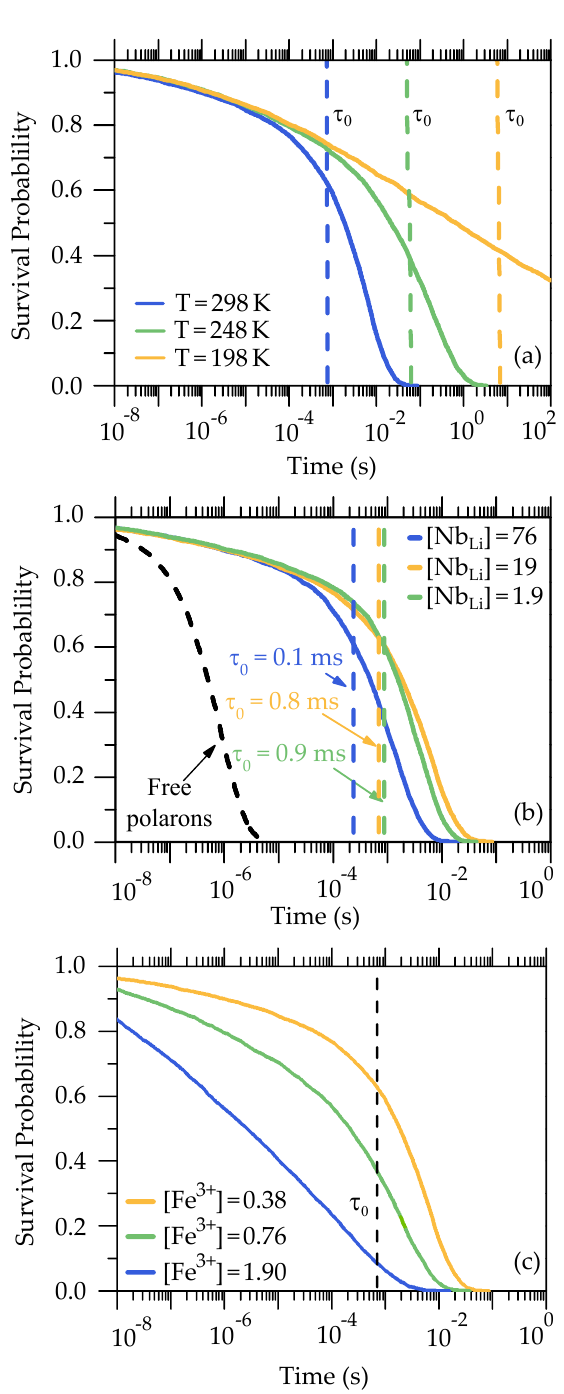
Figure 3. ( a ) Survival probability of P polarons at 298 K, at 248K and at 198K in a congruent sample with the same composition as the one in Figure 2. The dashed lines indicate the value of τ 0 as approximately determined by (12). ( b ) Survival probability for P polarons at room temperature in a sub-congruent ( blue ), congruent ( green ) and near-stoichiometric sample ( yellow ). The blackdashed line shows for comparison a decay of a population of F polarons in a fully stoichiometric sample. The numbers in the legend indicate the Nb Li concentration in × 10 25 m − 3 . ( c ) Survival probability for P polarons at room temperature in a congruent sample for increasing Fe concentrations. The dashed line indicates the hopping characteristic time τ 0 . The numbers in the legend indicate the Fe 3 + concentration in × 10 25 m − 3